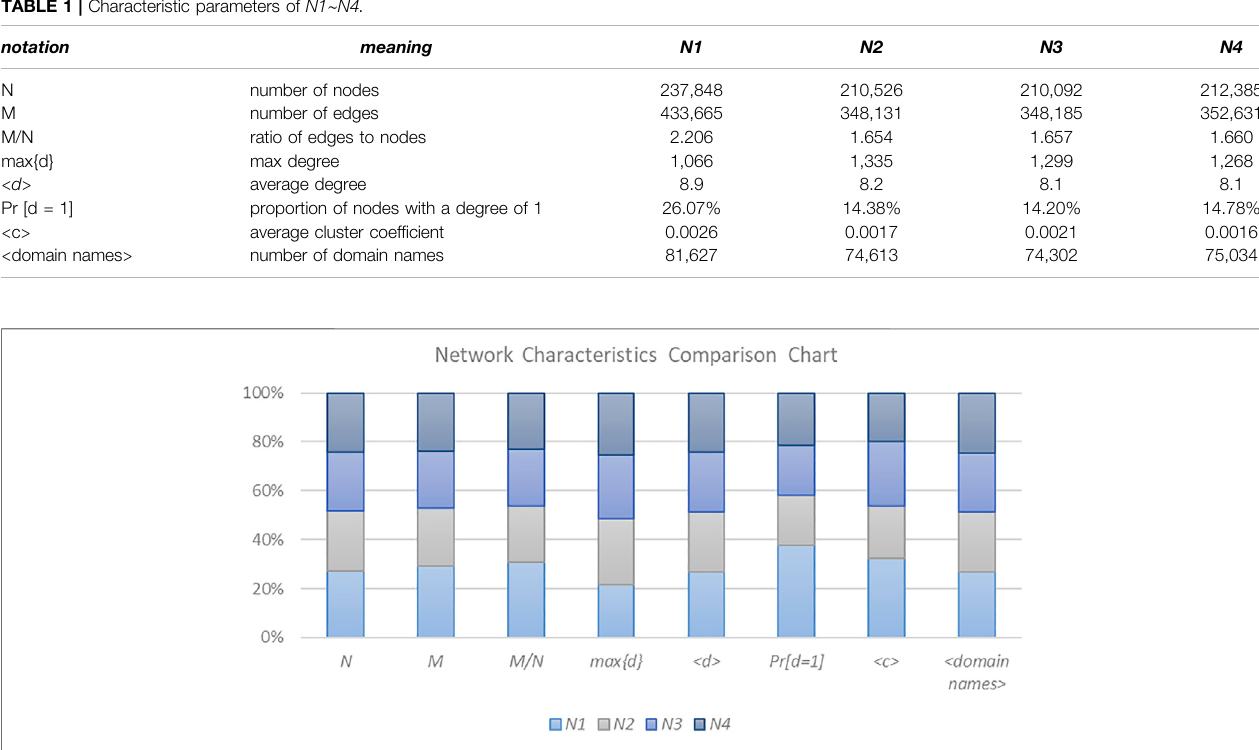
FIGURE 8 | Comparison of characteristic parameters of N1-N4.